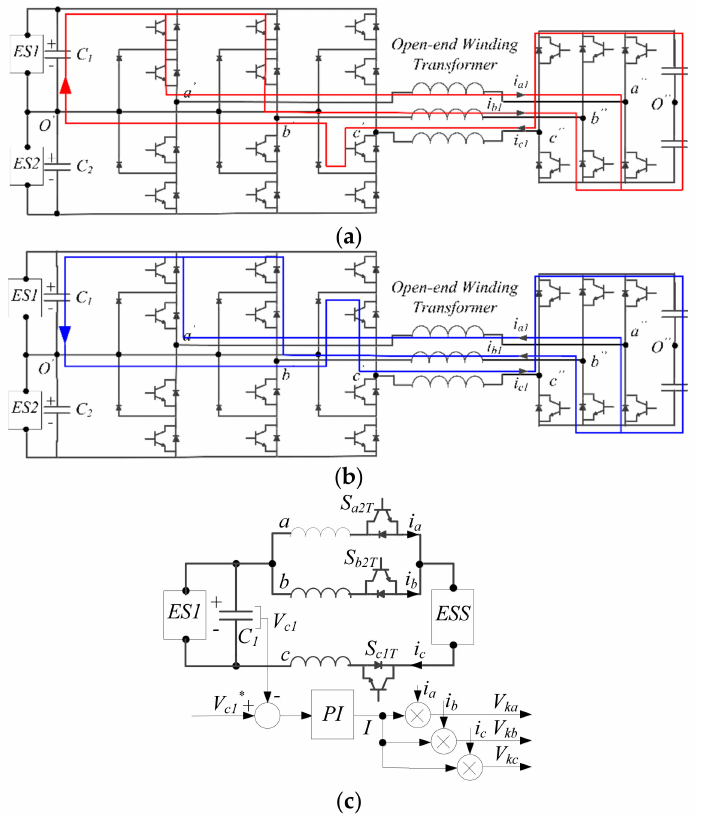
Figure 5. Three-level inverter (3LI) + TLI: C 1 voltage control when the PPO vector is generated: